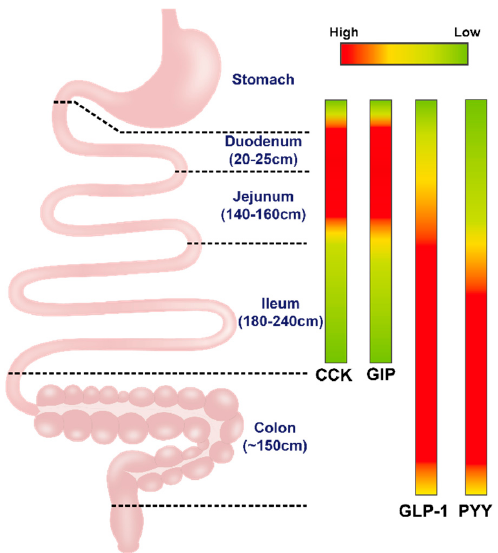
Figure 1. The density of enteroendocrine cells (EECs) secreting cholecystokinin (CCK), glucose-dependent insulinotropic polypeptide (GIP), glucagon-like peptide 1 (GLP-1) and peptide YY (PYY) in the duodenum, jejunum, ileum and colon.